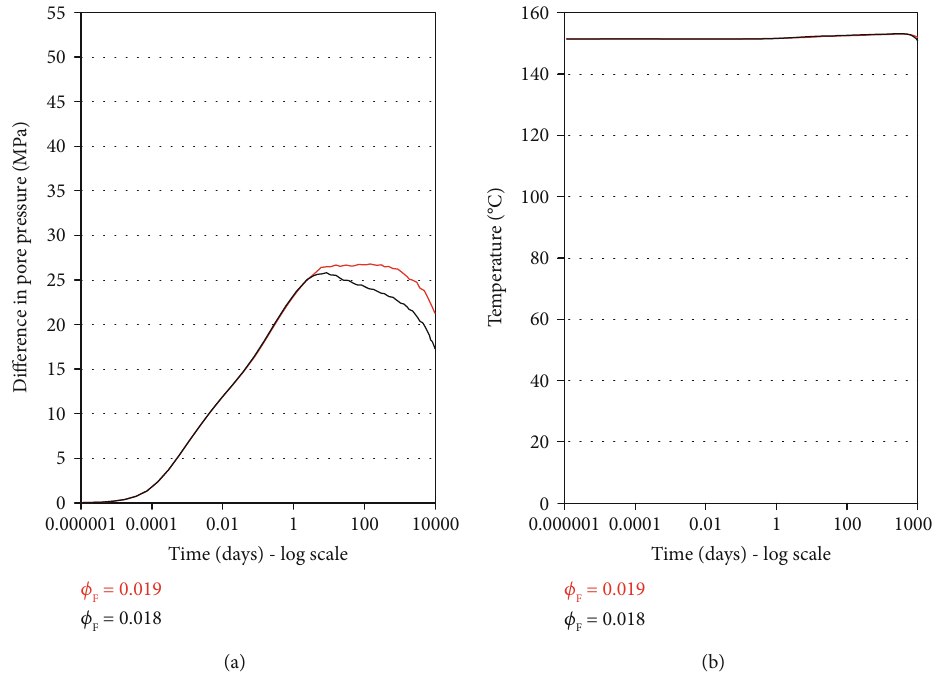
ff erence in the fl uid pore pressure between the Figure 13: E ff ect of the residual porosity ϕ F of the fracture zones on the time evolution of the di injection and production boreholes (a) and the temperature at the production borehole